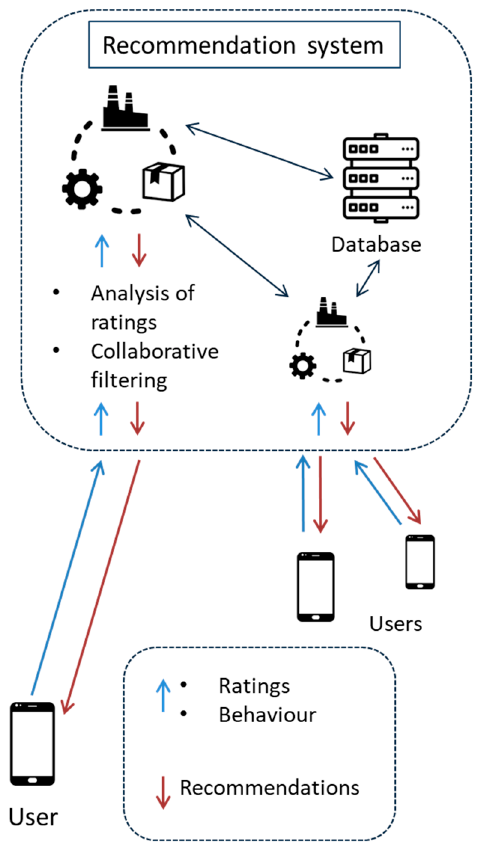
Figure 2. Recommendation system architecture.